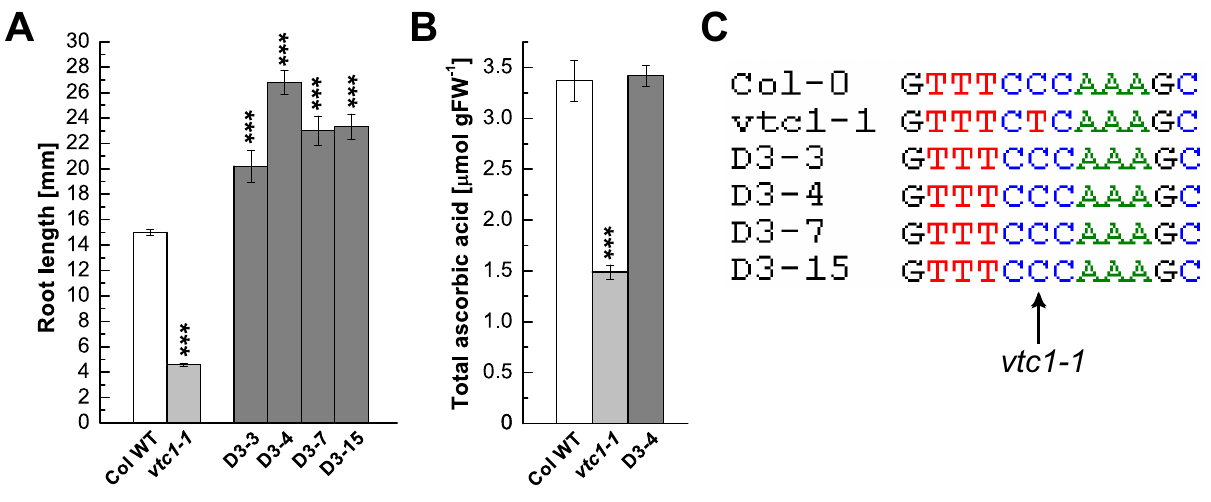
Figure 2. Phenotypic and genotypic characterization of additional vtc1-1 suppressor mutants. ( A ) Root length in seven-day-old seedlings grown on 1× MS. Bars represent means ± SE of 18-73 individuals. Since D3-4 homogenously produced long roots, all individuals were included in the calculations. As D3-3, D3-7, and D3-15 developed long and short roots in an approximate 3:1 ratio, only individual seedlings that produced long roots were included in the calculations. ( B ) Total ascorbic acid content per gram fresh weight in whole rosettes of three-week-old plants. Bars represent means ± SE of three (Col-0 and vtc1-1 ) or 24 individual replicates. *** P < 0.001 by Student’s t -test indicates significant differences in comparison to the Col-0 wild type. ( C ) Sequences of the Col-0 wild type, the vtc1-1 mutant and four suppressor mutants. The arrow points to the vtc1-1 mutation, a conversion of cytosine to a